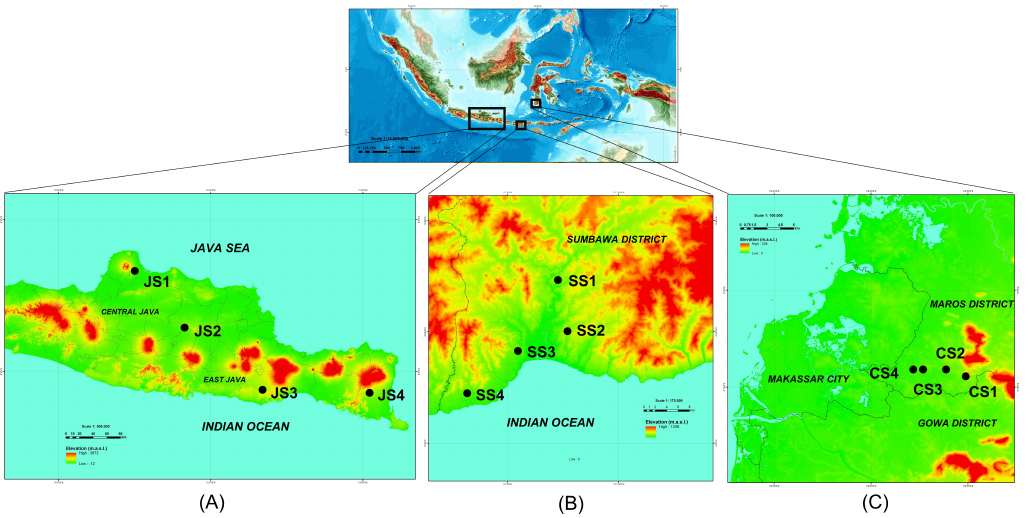
Figure 1. Map showing the twelve sites (black circles) in Indonesia’s Java ( A ), Sumbawa ( B ), and Su- lawesi islands ( C ). The first and the second letters indicate the island and site (J = Java, S = Sumbawa, C = Sulawesi). The third letters are the number of sites on each